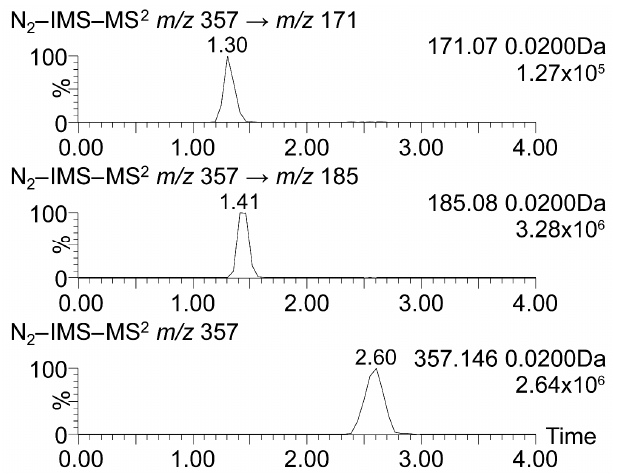
Figure 3 Figure 3. N 2 -driftgrams of precursor and major product ions originating from m / z 357 ion. The top panel shows m / z 171 (C 8 H 11 O 4 - ), the middle panel shows m / z 185 (C 9 H 13 O 4 - ), and the bottom panel shows m / z 357 (C 17 H 25 O 8 - ). The time axis is in